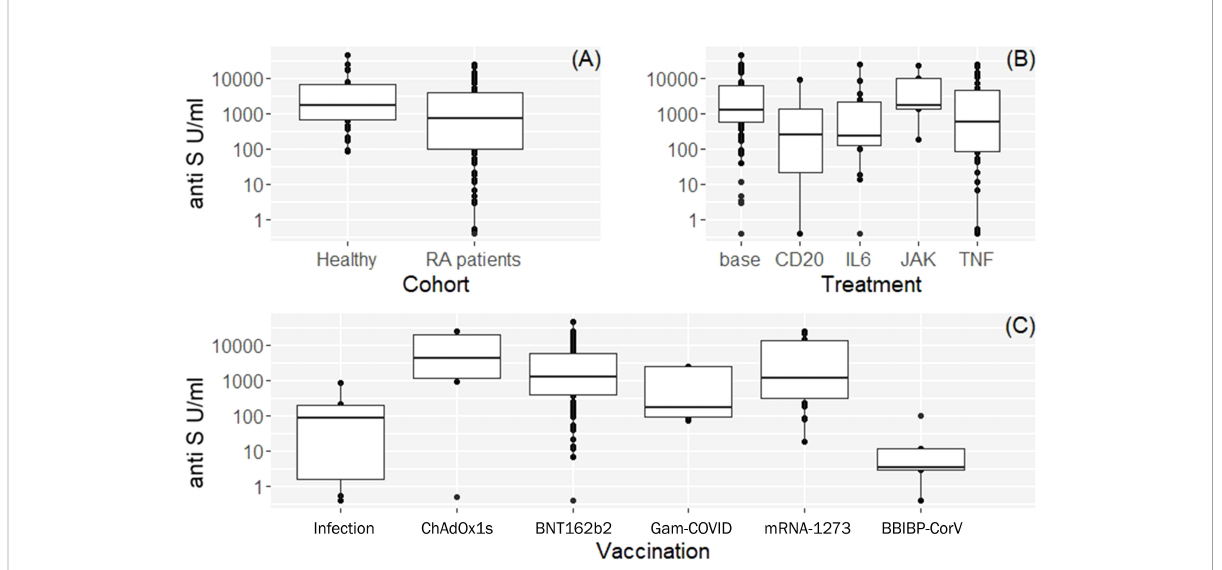
FIGURE 1 Box plots of vaccine or infection induced anti-S antibody levels and demographic characteristics of the study participants. (A) Observed anti-S antibody levels by cohorts. (B) Anti-S antibody levels by targeted drug treatment modalities in the combined data set (both cohorts). Base: means healthy volunteers or RA patients on csDMARDs and/or steroids. (C) Anti-S antibody levels after different vaccines available in Hungary in RA patients and healthy volunteers. See Table 1 for additional and more detailed numeric